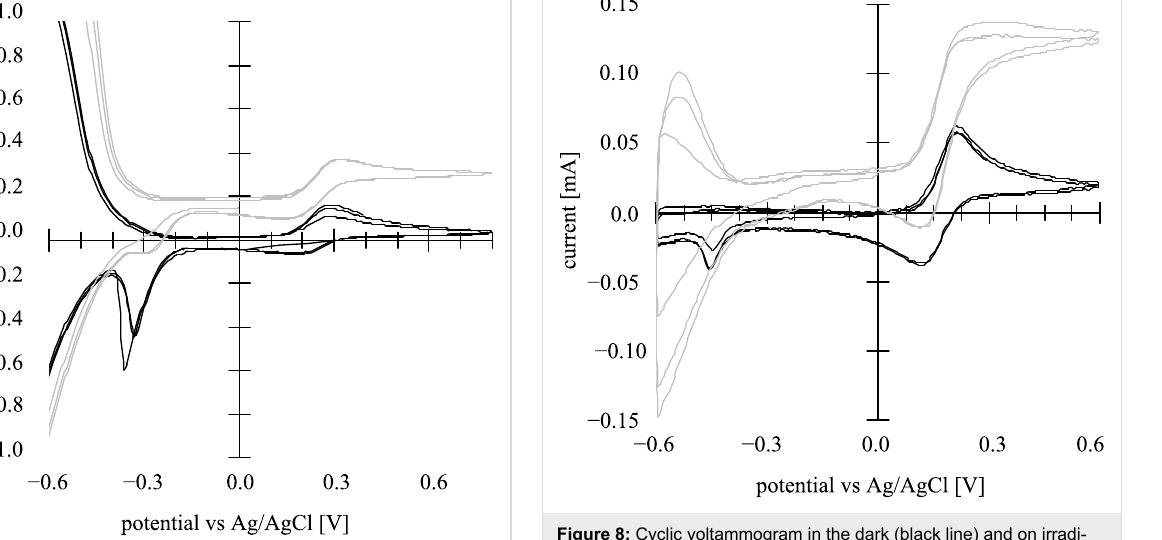
Figure 8: Cyclic voltammogram in the dark (black line) and on irradi- ation (gray line) at a nanoporous TiO 2 (G2) photoanode (1 cm × 1 cm)